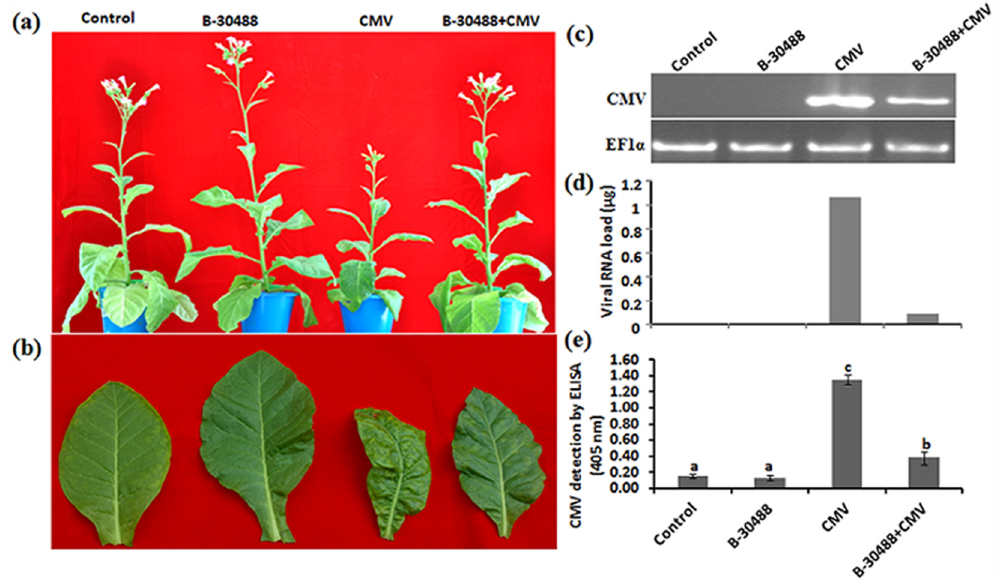
Fig 1. PGPR promoted the tobacco health and reduced virus load. (a) N . tabacum cv. White Burley plants showing induced growth at 28 dpi in B-30488 treated plant with or without CMV infection as compared to healthy (control) and disease (CMV) plants. (b) A close view of 3 rd tobacco leaf from top showing disease severity and chlorophyll differences. (c) Ethidium bromide stained agarose gel image showing high virus accumulation in leaf of CMV infected plant (CMV) as compared to B-30488 protected plant (B-30488+CMV). (d) Graphical representation of viral RNA load suggesting high CMV accumulation in infected tobacco (CMV) plant as compared to B-30488 protected plant (B-30488+CMV). Concentration of viral RNA was quantified by semi-quantitative PCR using CMV-coat protein (CP) gene specific internal primers and tobacco elongation factor 1alpha (EF1 α ) gene was used as an internal plant control. (e) Enzyme linked immunosorbent assay (ELISA) of upper leaves showing virus accumulation levels at 28 dpi. Plants were challenged with inoculum diluted ten times prepared from the leaves of tobacco infected with Cucumber mosaic virus (CMV)-A. Bar lines on each histogram indicate the standard error.